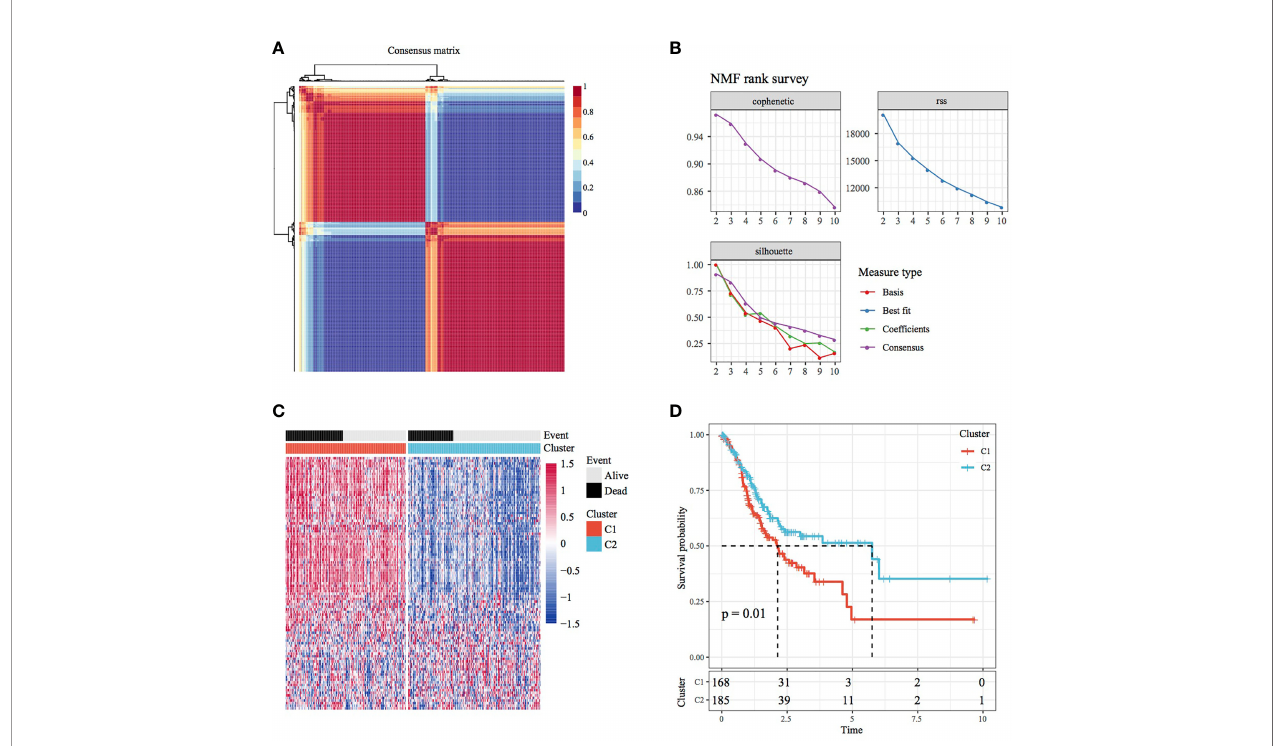
FIGURE 1 | Molecular subtypes of STAD based on invasion-related genes. (A) Consensus map of NMF clustering. (B) Distribution of cophenetic, RSS and dispersion with a rank of 2 – 10. (C) Heat map of 40 prognosis-related gene clusters. (D) Prognostic survival curve of STAD in molecular